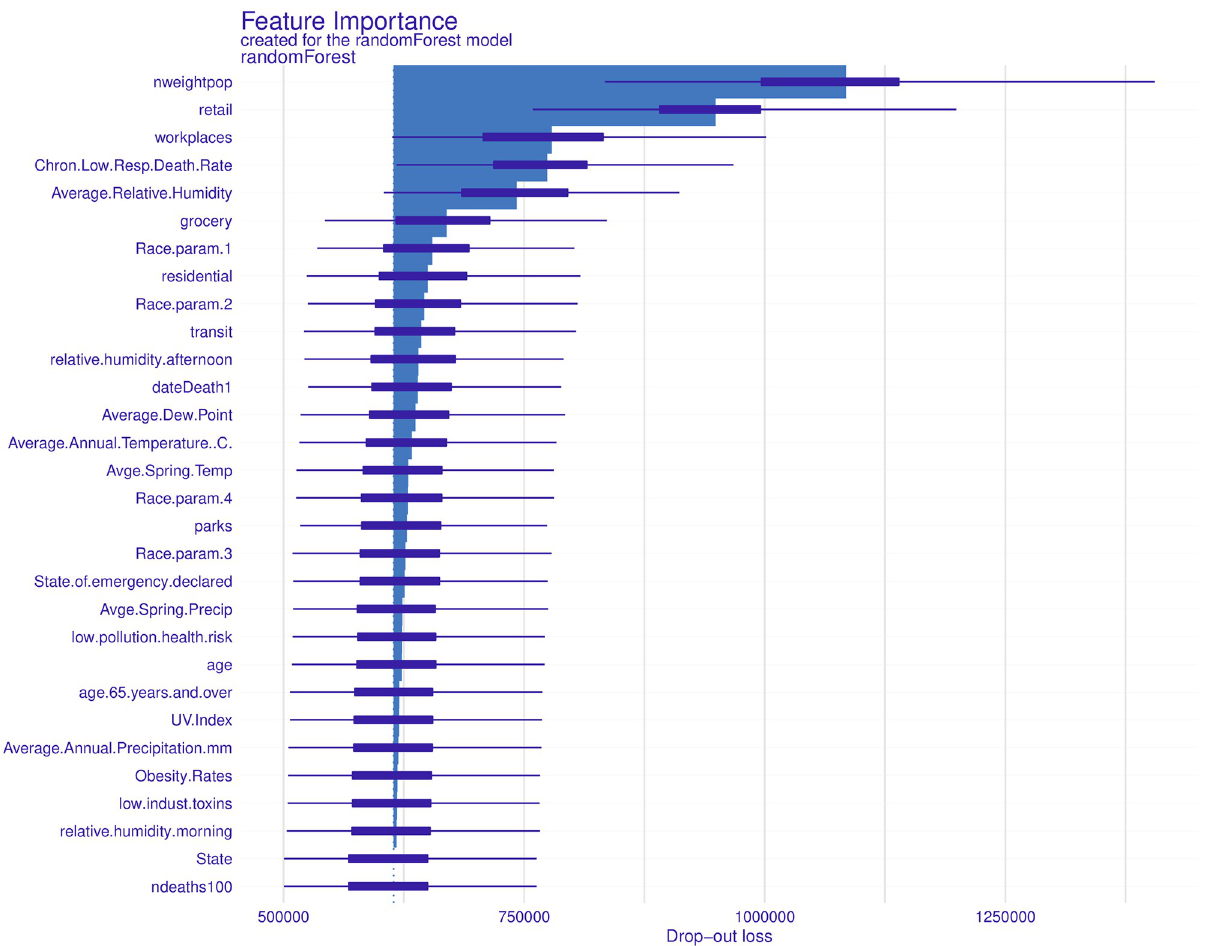
Fig 3. Relative importance of explanatory variables using the DALEX method. See text for more